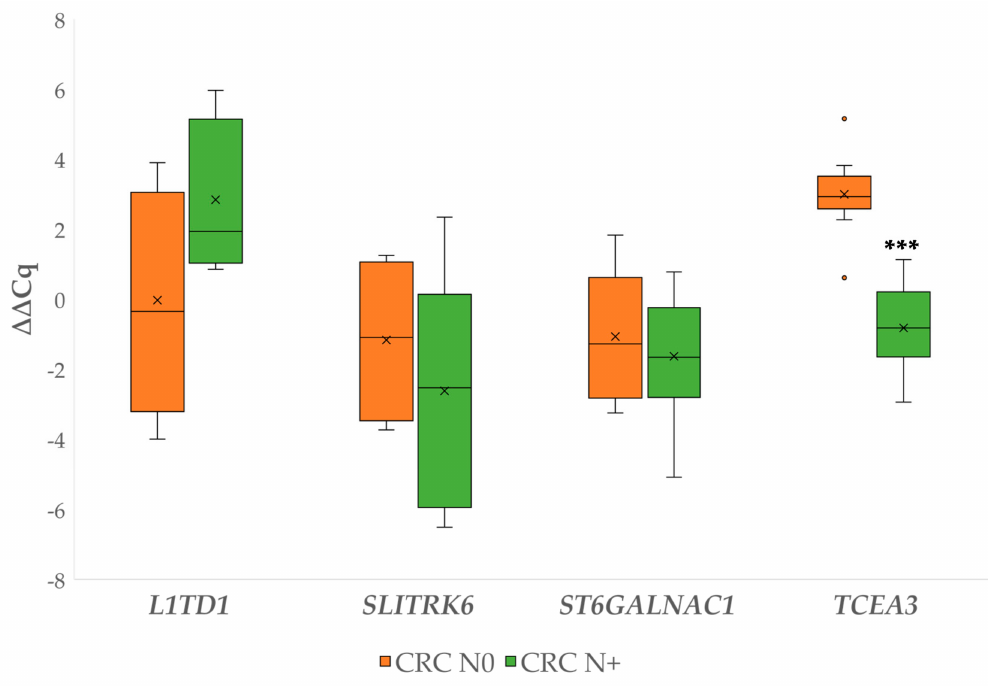
Figure 4. Expression ( ∆∆ Cq) of the investigated genes ( L1TD1 , SLITRK6 , ST6GALNAC1 , TCEA3 ) in carcinoma without and carcinoma with lymph node metastases. Legend: CRC N0, colorectal carcinoma without lymph node metastases; CRC N+, colorectal carcinoma with lymph node metastases; x, mean; ◦ , outlier; *** p ≤